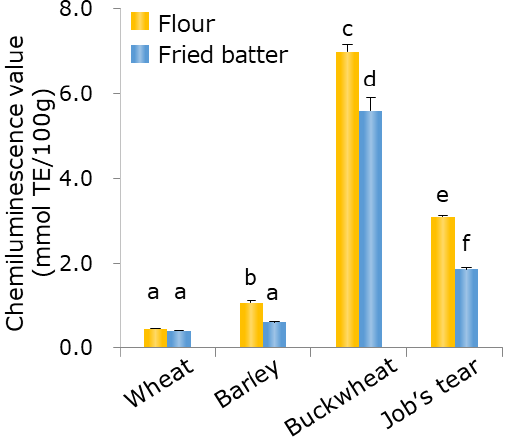
Figure 2. Peroxyl radical scavenging capacity in the four flours examined in this study. The IC 50 value was defined as the sample density that was half the value of the phosphate buffer solution wherein light emissions did not include an antioxidant component. Results are expressed as Trolox equivalents and measured using a chemiluminescence-based assay. Each value represents the mean ± SD ( n = 3). Different letters a-f for flours and fried batter indicate a significant difference ( p < 0.05, Tukey test). Table 1. Peroxide value (PV) and p -anisidin value (AnV) of oil after frying in the four flours examined in this